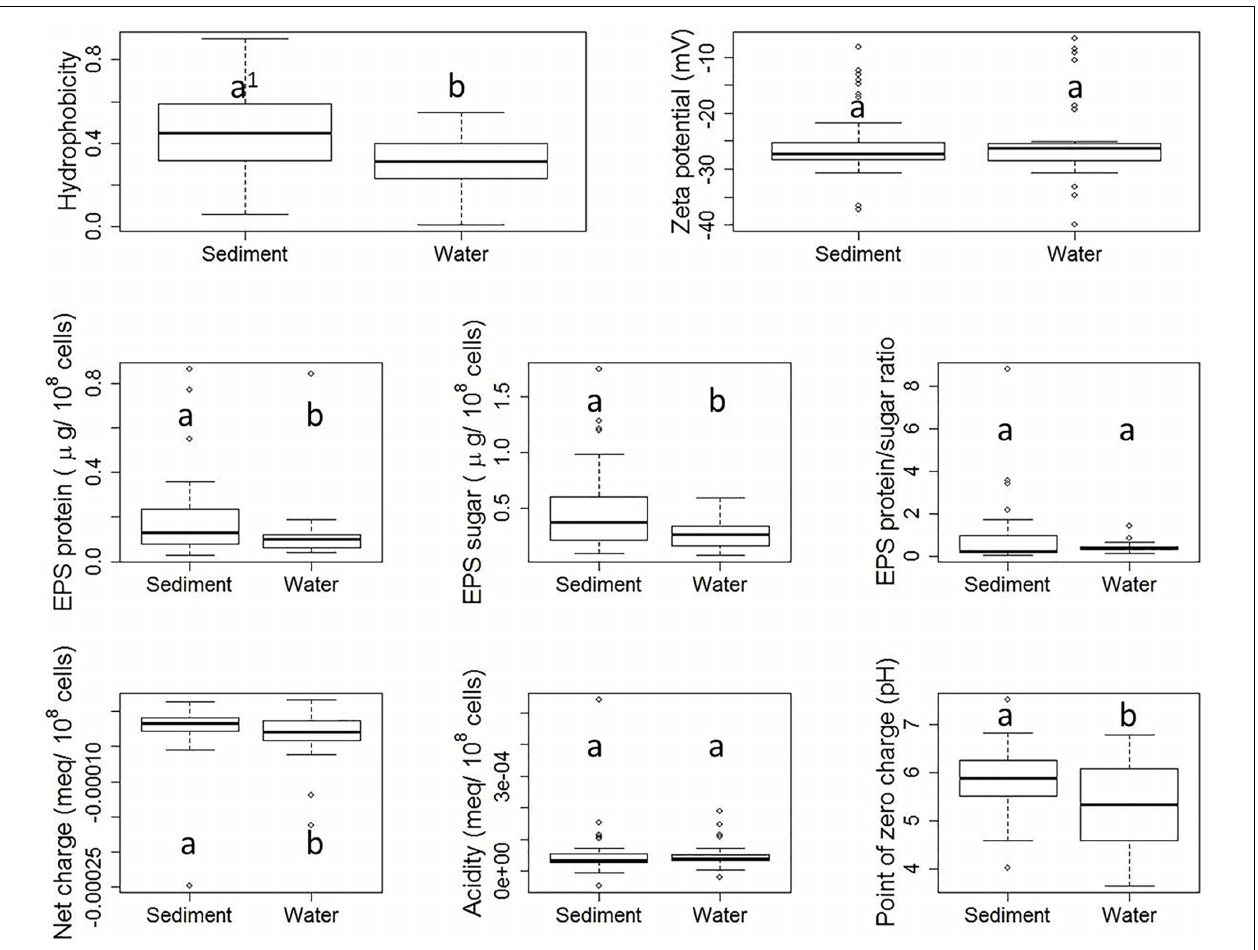
FIGURE 3 | Boxplots of property results from stream sediment E. coli and stream water E. coli . Each plot shows five numerical values: the smallest observation ([Q1 = Q2 − 1.5(Q4 − Q1)], the low end of the whisker), 25% quartile (Q2, low boundary of box), median (Q3, the band near the middle of box), 75% quartile (Q4, high boundary of box), and largest observation ([Q5 = Q4 + 1.5(Q4 − Q1)], the high end of the whisker). Outliers, if any, are indicated by dots. Within each subplot, values with the same letter are not different at the significant level. The difference is determined by a Wilcoxon test with significance level set at α =